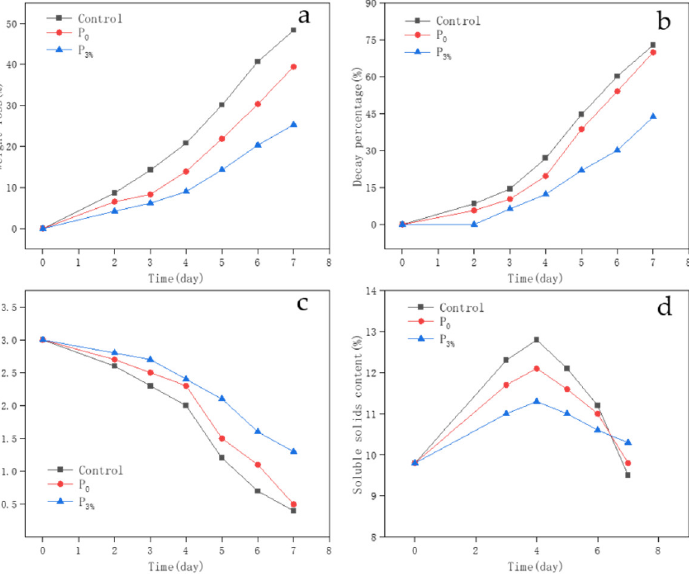
Figure 10. Effects of coated and uncoated paper on percentage decay ( a ), weight loss ( b ), firmness ( c ) and soluble solids content ( d ) during strawberry storage at room temperature.